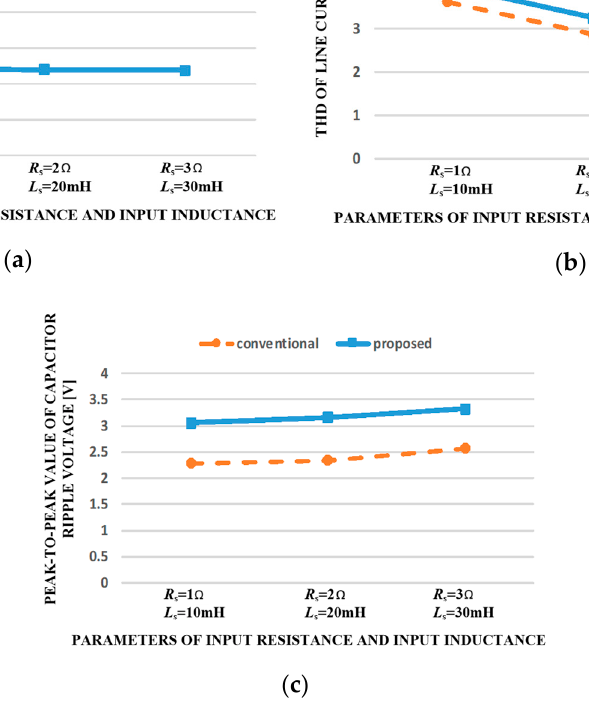
Figure 15. Effects of input resistance and input inductance on ( a ) average number of switching ( b ) THD of line current ( c ) peak-to-peak value of capacitor ripple voltage of the conventional and the proposed methods.